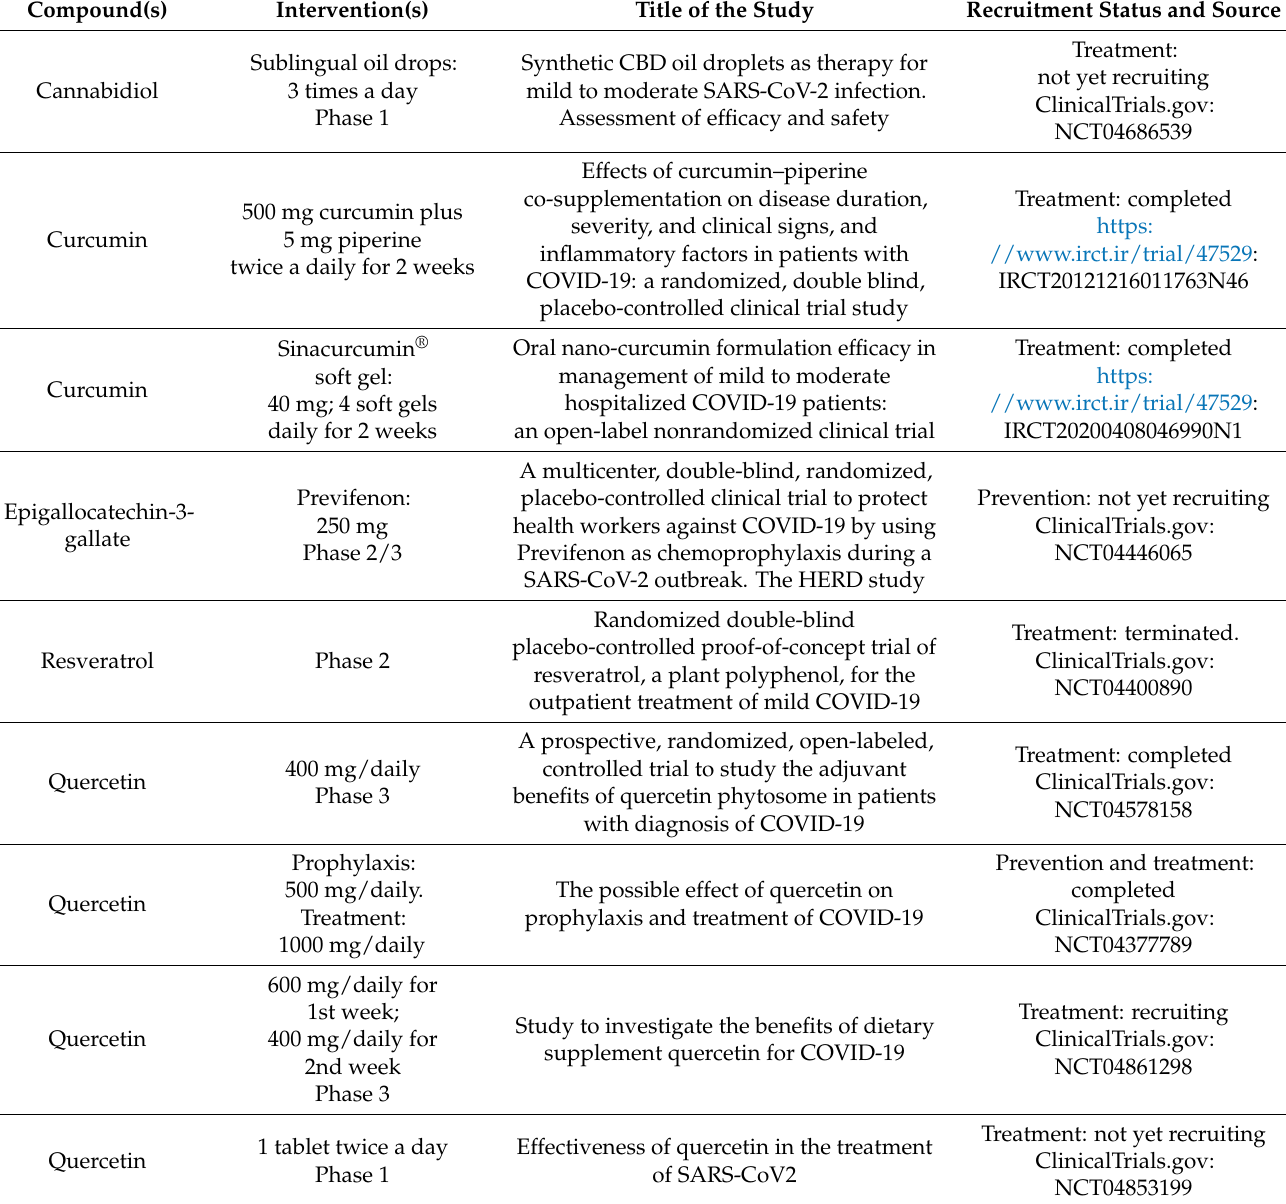
Table 2. Clinical trials approved for the use of polyphenols for